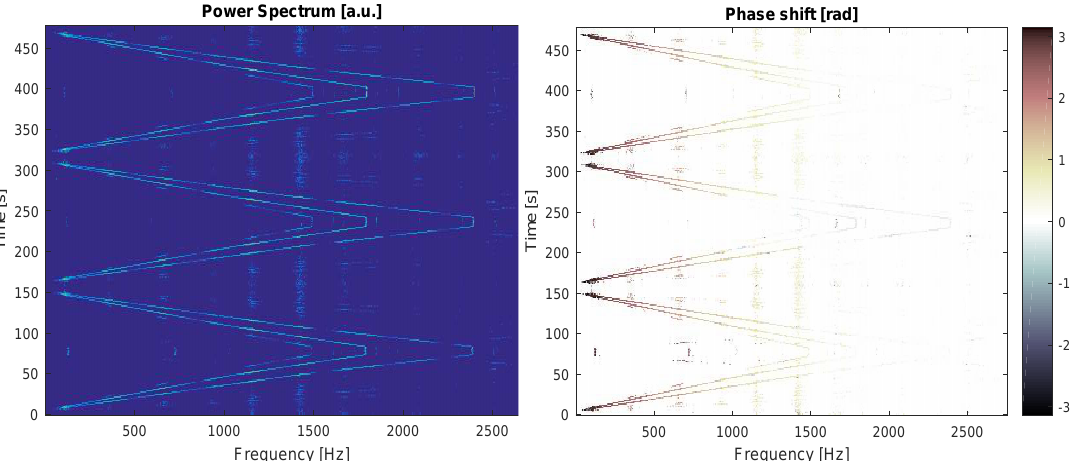
Figure 18. Three consecutive frequency scans (ramp up and down) using the multimodal wheel. ( Left ): Power spectrum, ( right ): Phase